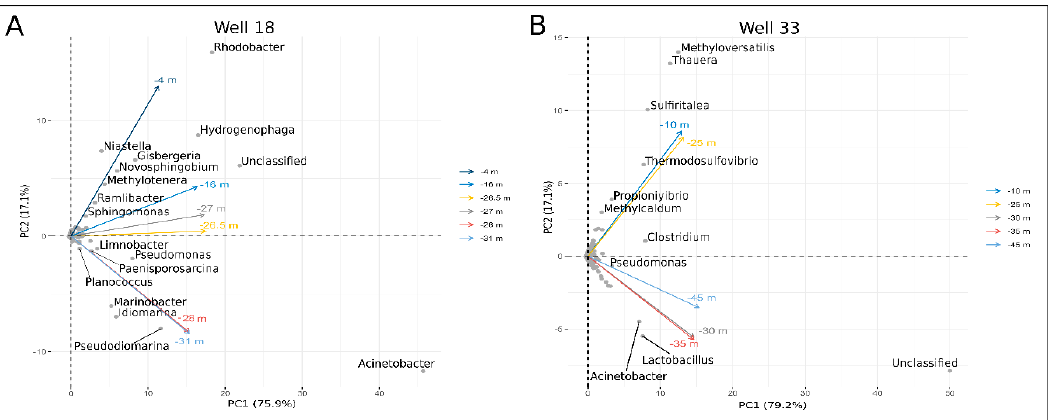
Figure 9. Principal component analysis (PCA) ordination of microbial communities found at different depths in wells 18 ( A ) and 33 ( B ) based on relative abundances at the genus level.